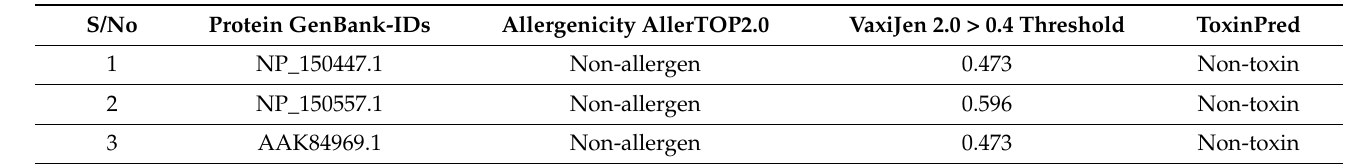
Table 1. The top-ranked vaccine candidate proteins of LSDV for designing multi-epitope vaccine constructs models.